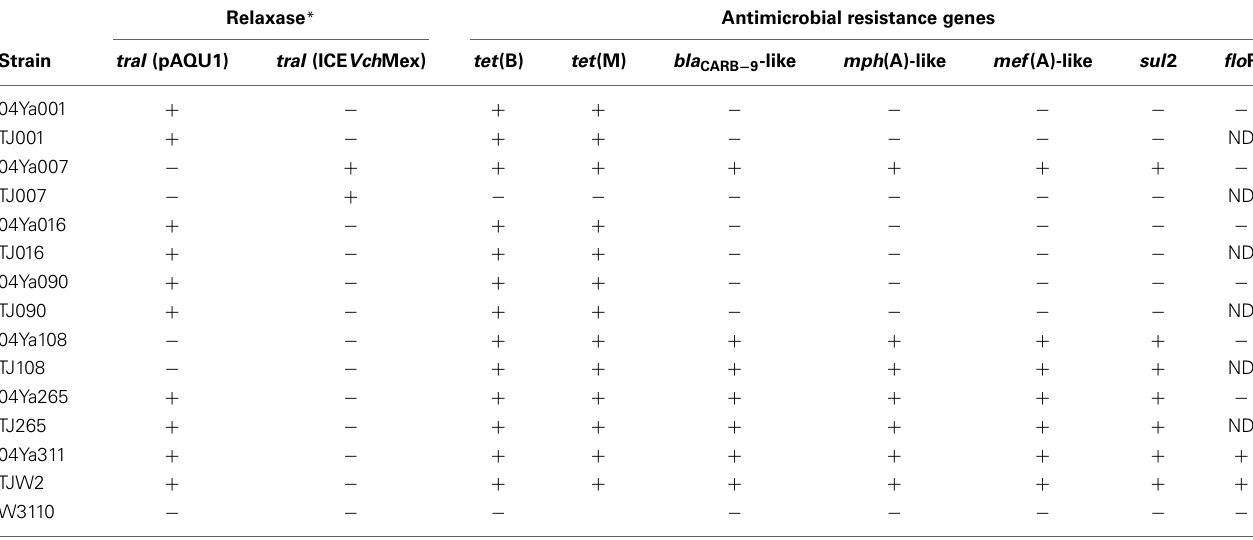
Table 5 | Detection of traI and other antimicrobial resistance genes in donors and transconjugants by PCR. Relaxase